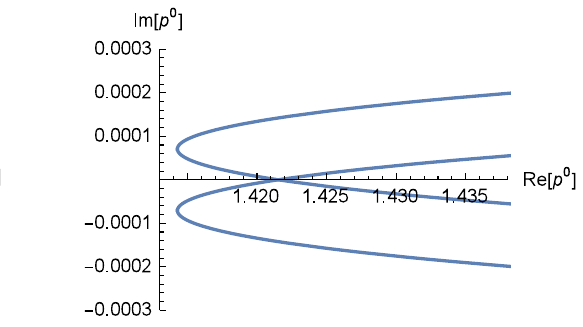
Figure 15 . Areas of LW pinching when M 0